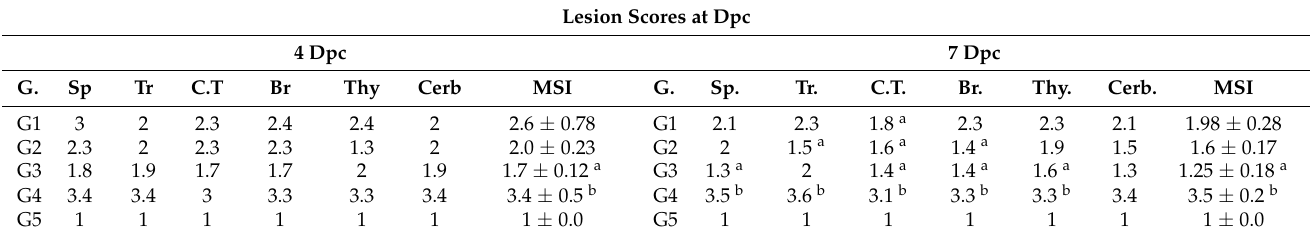
Table 3. Microscopic lesions score in vaccinated and non-vaccinated challenged groups on day 28 with VNDV genotype VII.I.I. Lesion Scores at